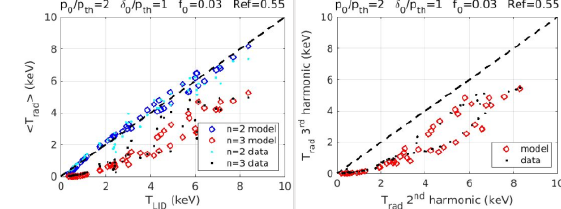
Fig. 10. As in Fig. 9, for pulse 96850. Perturbation Fig. 11. As in Figs. 7-10, for DT discharges and data points with NBI only. Perturbation parameters: f 0 = 0.03, p 0 /p th = 1.35,  /p th =